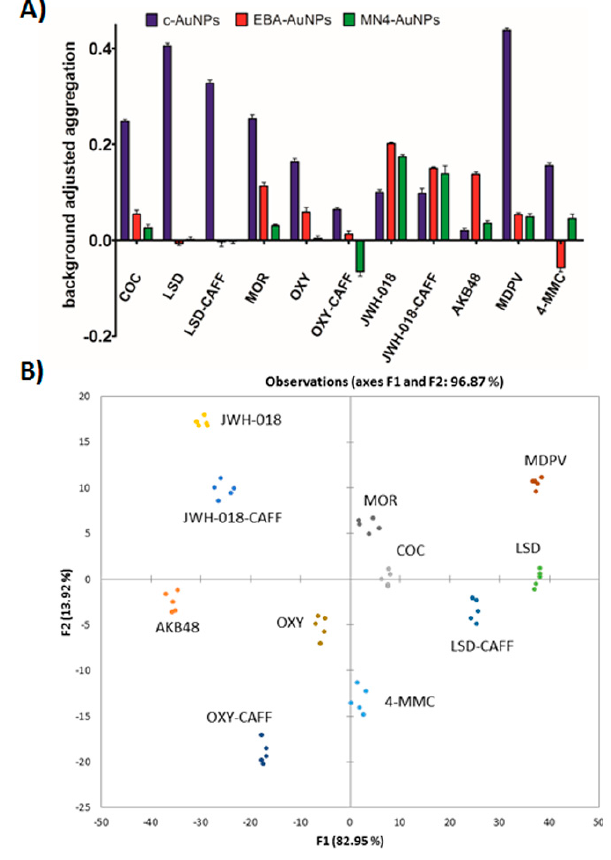
Figure 5. Controlled substance classification. ( A ) Background corrected aggregation data (30 s incubation with NaCl) used as an input in discriminant analysis; ( B ) Clustering plot based on the first two canonical factors.